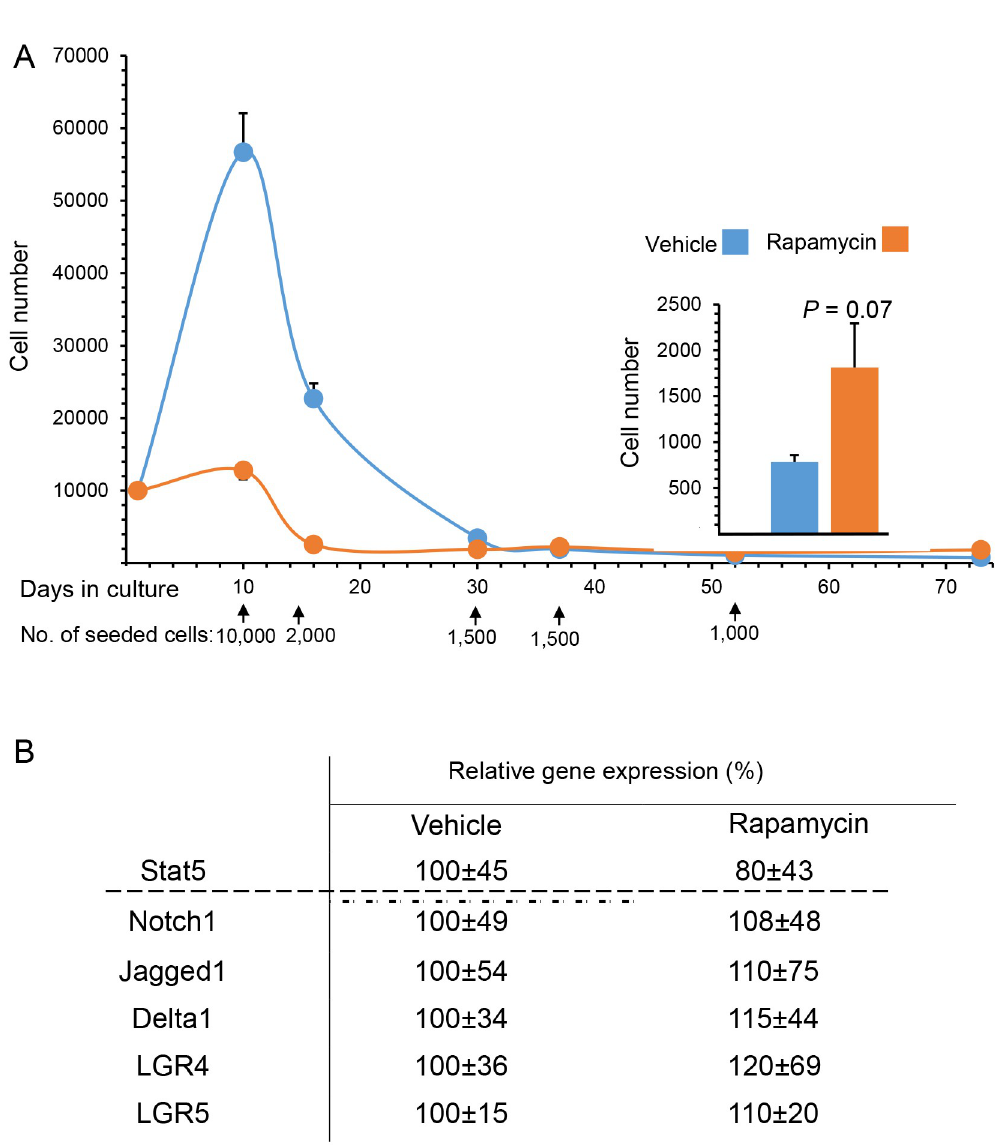
Fig 3. Intramammary rapamycin administration induces self-renewing cell properties. A. Rapamycin administration induces propagation rate of cultured mammary epithelial cells. Dispersed cells isolated from individual vehicle- and rapamycin-treated mammary glands were seeded in 96-well plates and cultured in mammary medium. At the indicated time points (arrows), cells were trypsinized, counted and reseeded. Inset: cell number at the end of the culture period. Bars represent mean ± SEM. B. Relative gene expression analysis of luminal progenitor marker (Stat5) and stem cell markers (Notch1, Jagged1, Delta1, LGR4, LGR5). N = 4 for vehicle-treated and 3 for rapamycin-treated glands. Six wells of cells from each gland were